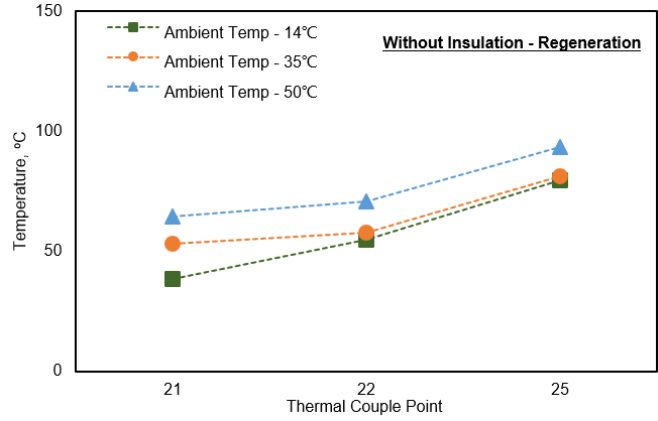
Figure 9. Max temperature at aftertreatment neighboring parts on vehicle.